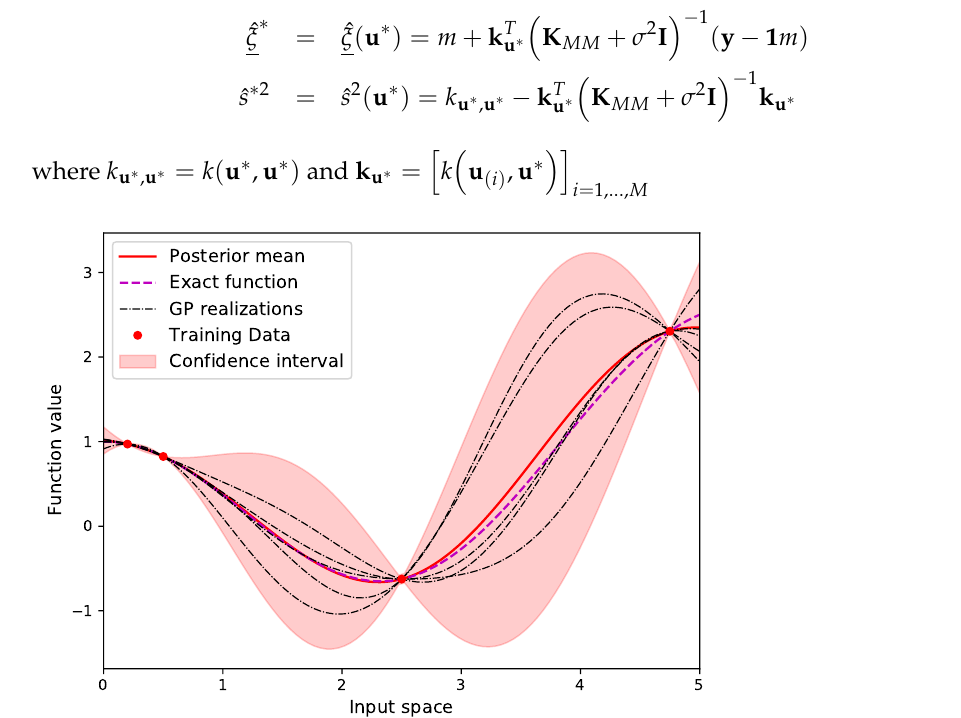
Figure 1. Example of Gaussian process prediction and associated confidence